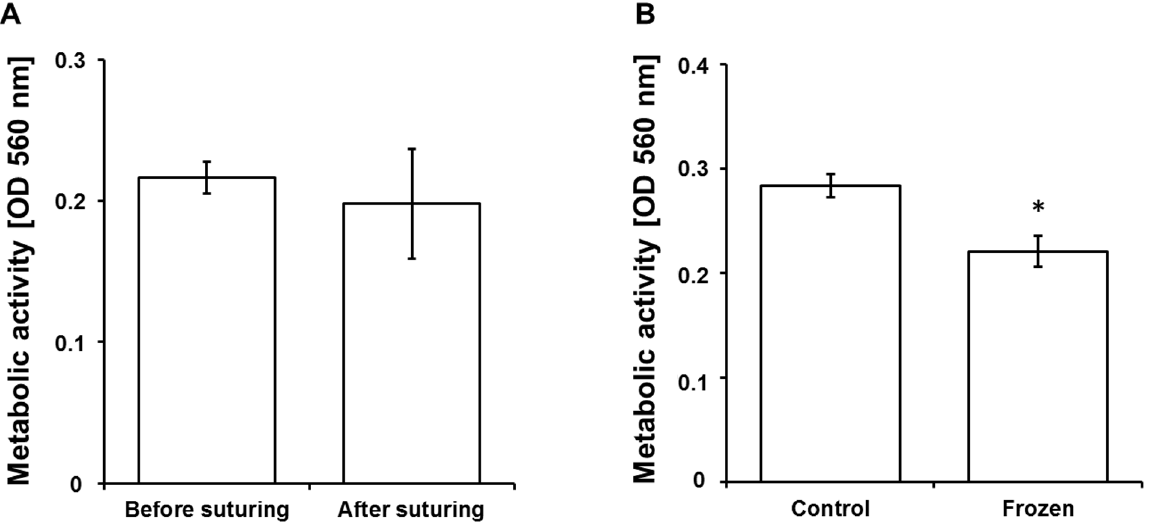
Figure 7. Clinical perspective. To determine the effect of mechanical stress on cell survival during suturing the metabolic activity of cell-filled sutures was determined before and after suturing in an ex vivo model using human skin, where no significant difference were observed (A). The potential to produce storable cell-filled sutures was evaluated. Therefore, the metabolic activity of ASCs in the suture was determined after freezing relative to unfrozen sutures. After freezing, 78% of the metabolic activity was preserved (B). p , 0.001.